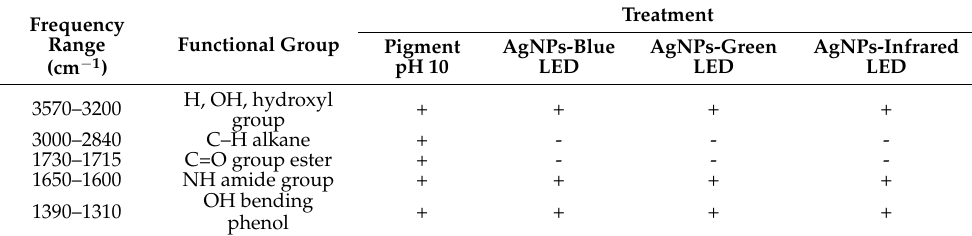
Figure 6. Fourier-transform infrared (FTIR) spectrum of T. purpurogenus extracellular pigment at pH 10 and fungus-mediated AgNPs biosynthesized using blue (AgNPs-blue LED), green (AgNPs-green LED), and infrared (AgNPs-infrared LED) LEDs. Table 3. Frequency range obtained by FTIR and the corresponding functional